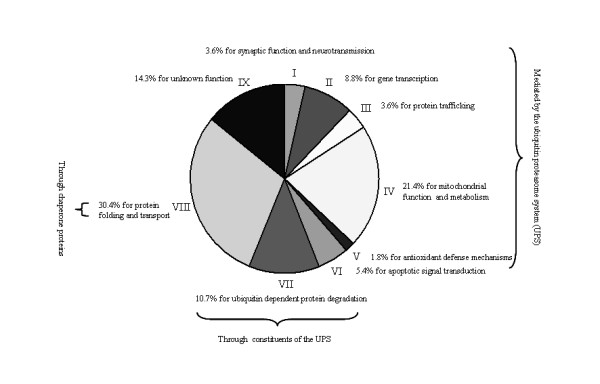
Functional categories of proteins identified in PSI-induced inclusions. This pie chart shows that all the identified proteins are classified into at least nine accepted categories as follows: 3.6% for synaptic function and neurotransmission (I); 8.8% for gene transcription (II); 3.6% for protein trafficking (III); 21.4% for mitochondrial function and metabolism (IV); 1.8% for antioxidant defense mechanisms (V); 5.4% for apoptotic signal transduction (VI); 10.7% for ubiquitin dependent protein degradation (VII); 30.4% for protein folding and transport (VIII); and 14.3% for unknown function (IX). When a protein could be divided into more than one class of functions, it was indicated as the best known class.